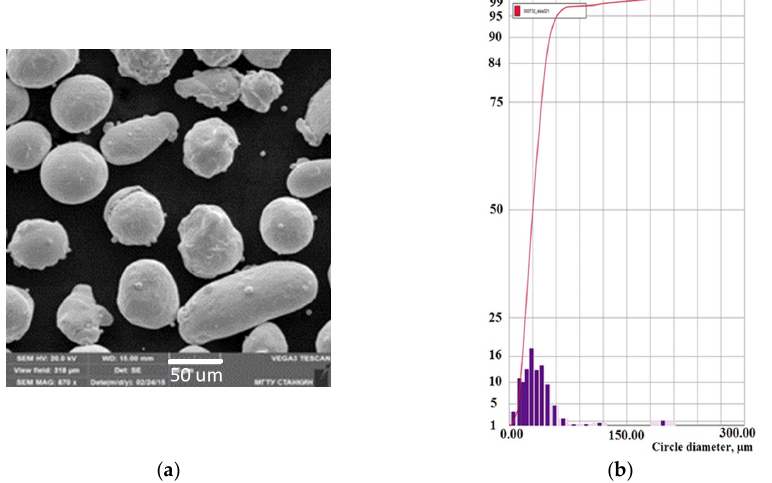
Figure 3. Morphology of powder particles PR12X18H10T: ( a ) magnification ×870; ( b ) integral curve and differential histogram of powder particle size distribution.